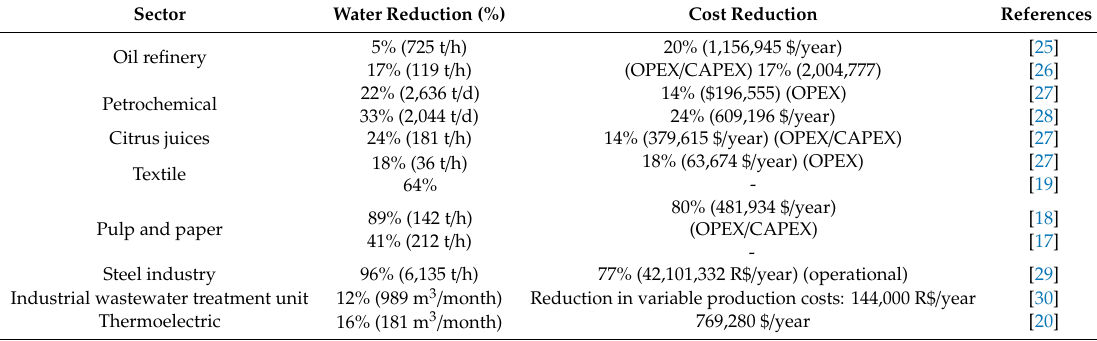
Table 2. Examples of potential for reduction of captured water and costs, obtained through the application of the WSD method to di ff erent industrial